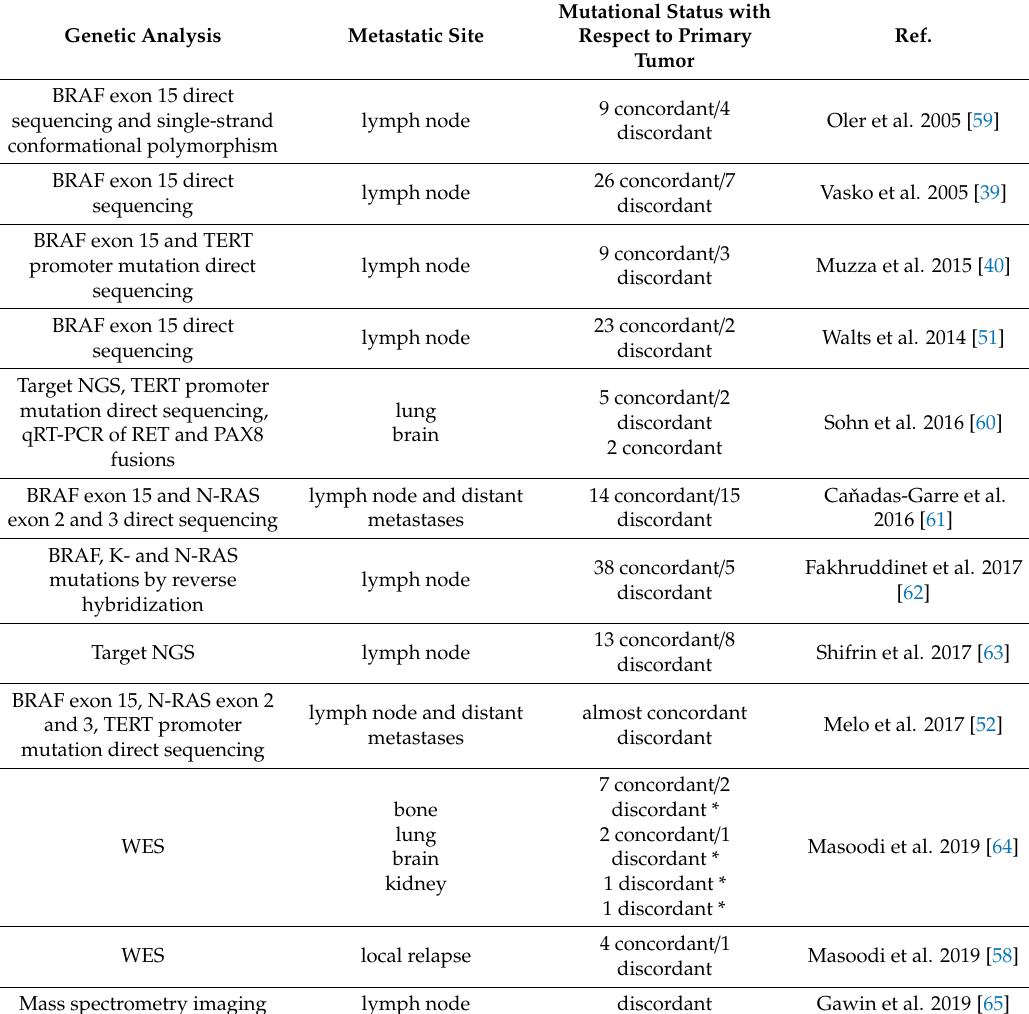
Table 3. Mutational status of metastatic sites with respect to corresponding primary papillary thyroid